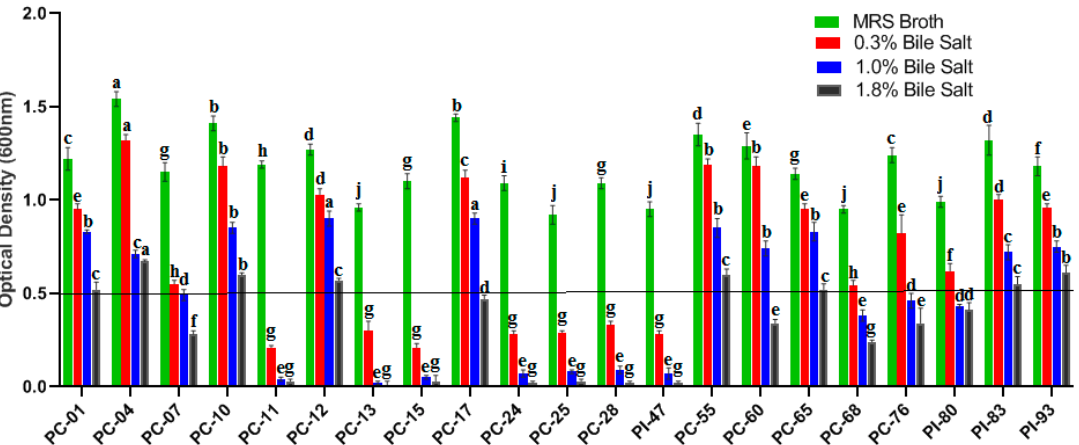
Figure 3. Growth of lactobacilli in MRS broth containing different concentrations of bile salts. Bars represented with the same alphabet shows a non-significant difference ( p value > 0.05) between isolates while bars represented with a different alphabet shows significant difference ( p value < 0.05) between isolates at different concentrations of bile salt.